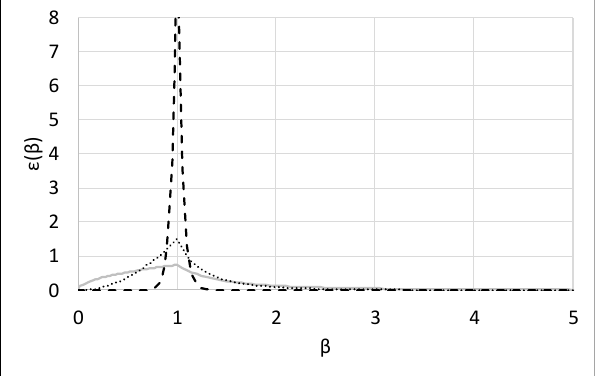
Figure 1. Probability distributions of simulated binary crossover (SBX) with three crossover distribution index (C DI ) values: C DI = 0.5 (solid gray line), C DI = 2.0 (dotted black line), and C DI = 20 (dashed black line).